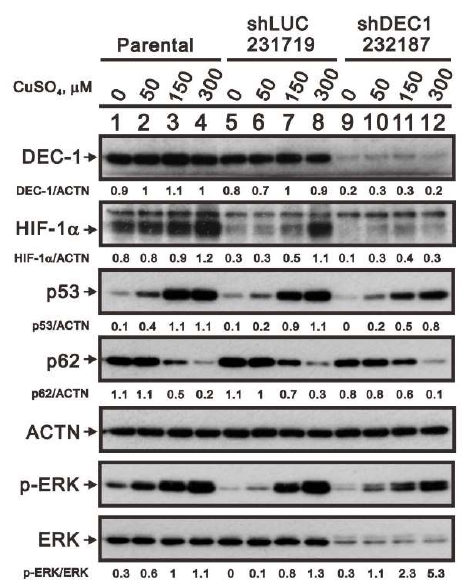
Figure 7. Copper sulfate acts via DEC1 to increase expression of related proteins. After DEC1 knockdown in HeLa cells, the cells were incubated for 6 h with the indicated concentrations of copper sulfate. Cell lysates were then subjected to western blotting with antibodies against DEC1, HIF-1 α , p53, total and p-ERK, and p62. ACTN served as the loading control. The results are representative of three independent experiments. Protein bands were quantified through pixel density scanning and evaluated using ImageJ, version 1.44a (http://imagej.nih.gov/ij/). The fold (shown above the bands) was normalized to internal control (ACTN). Phosphorylated ERK after normalization to total ERK protein is shown as the fold change.